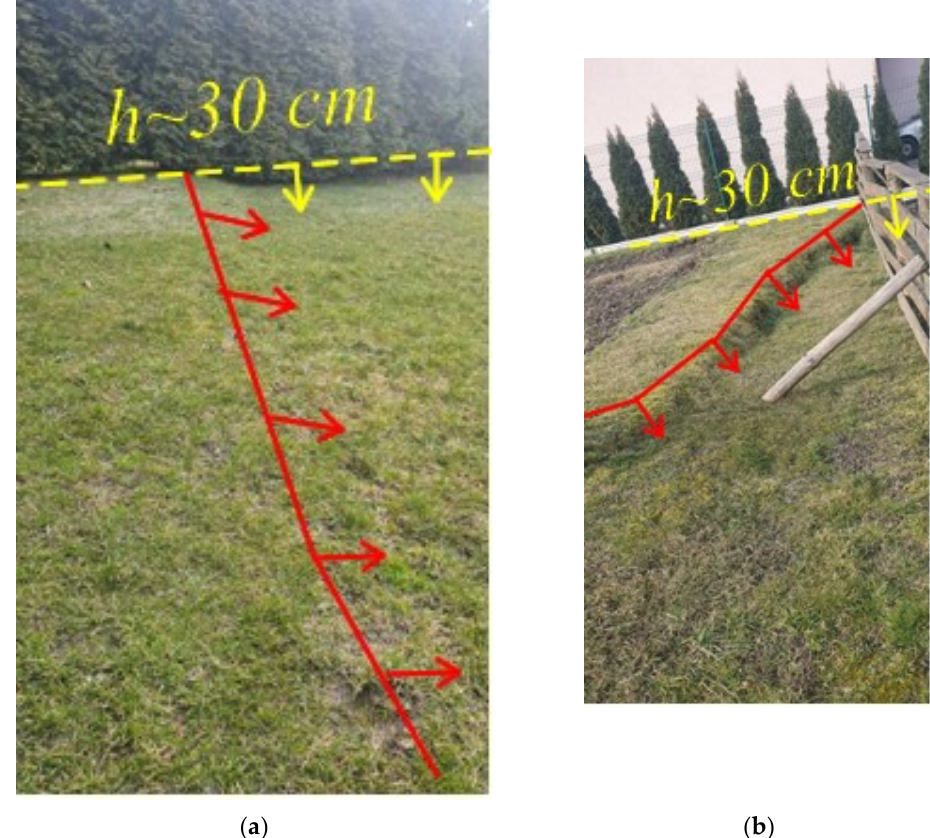
Figure 10. The view of discontinuity—“( a )” number 3; “( b )” number 5, h—the height of the fault throw.